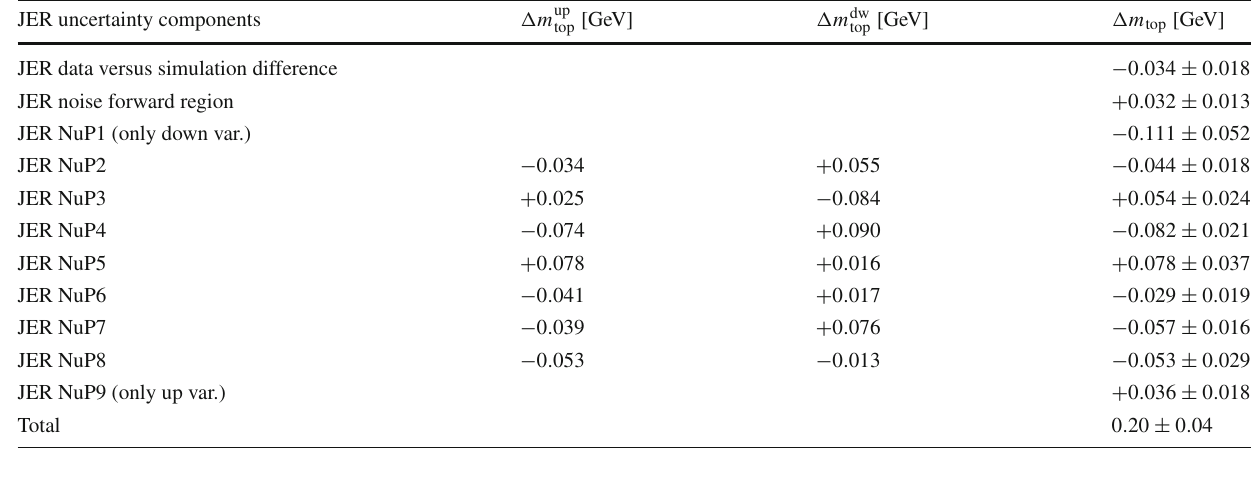
Table 12 The individual components of the flavour-tagging